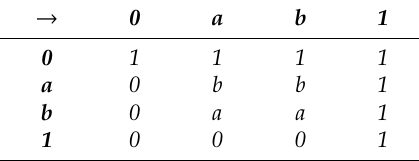
Table 12. The operation → on X .